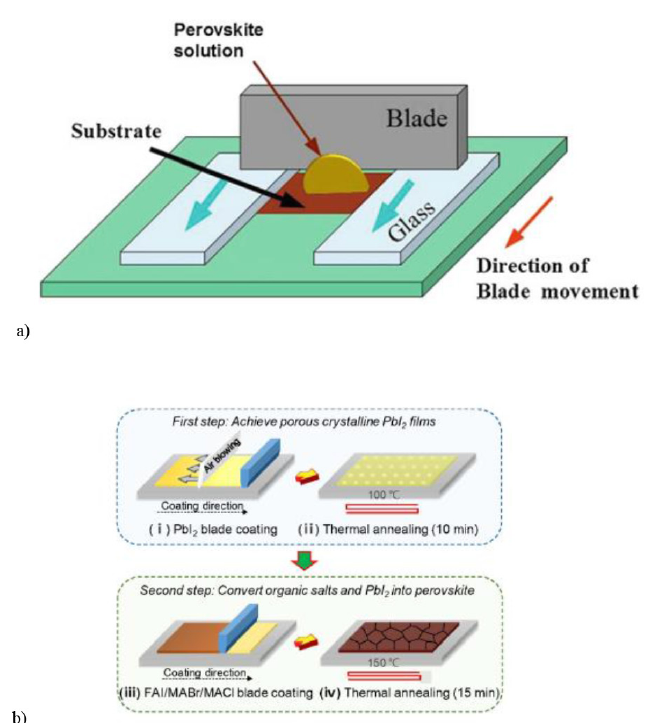
Fig. 16. – (a) Blade coating system [103]. (b) Schematic illustration of the sequential two-step blade coating of perovskite films: (i) blade-coating of PbI2 films assisted with gas blowing, (ii) Thermal annealing of PbI2 films, (iii) blade-coating of FAI/MABr/MACl, and (iv) thermal annealing of the perovskite film